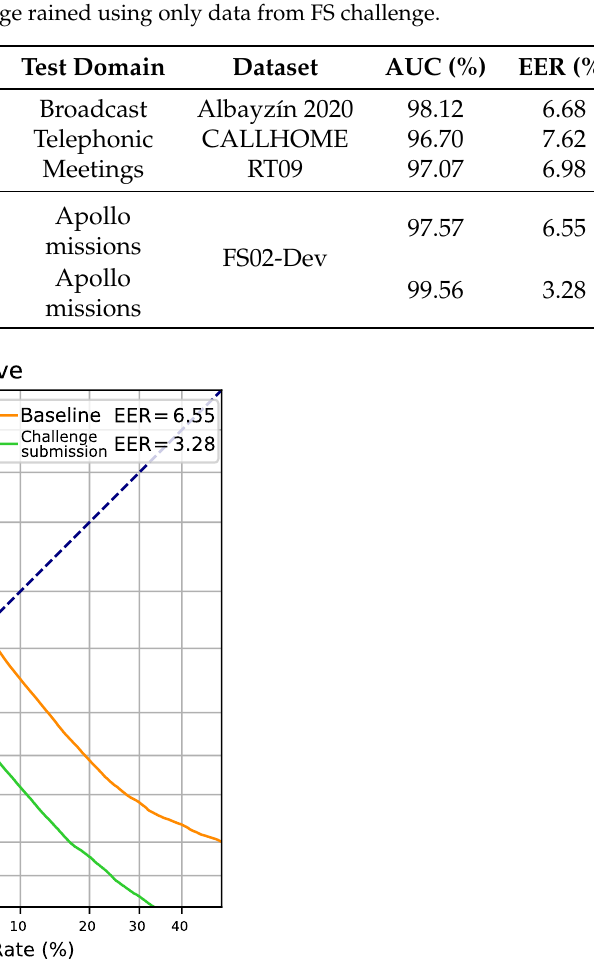
Figure 4. DET curve and EER (%) on FS02 development partition comparing a baseline system trained using out of domain data and our submission to the challenge trained using in domain